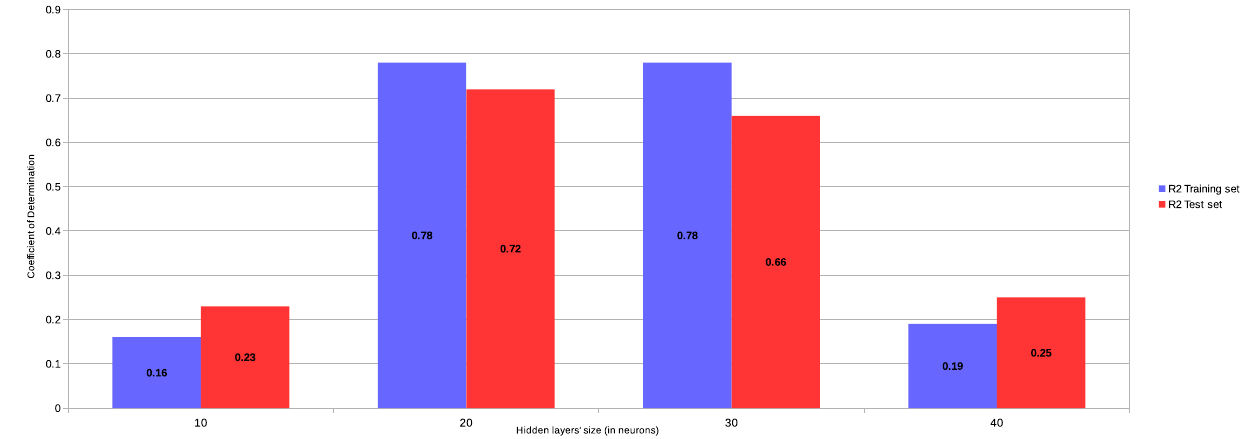
Figure 1. Regression model for interior point method—tuning the number of neurons (1 hidden layer).